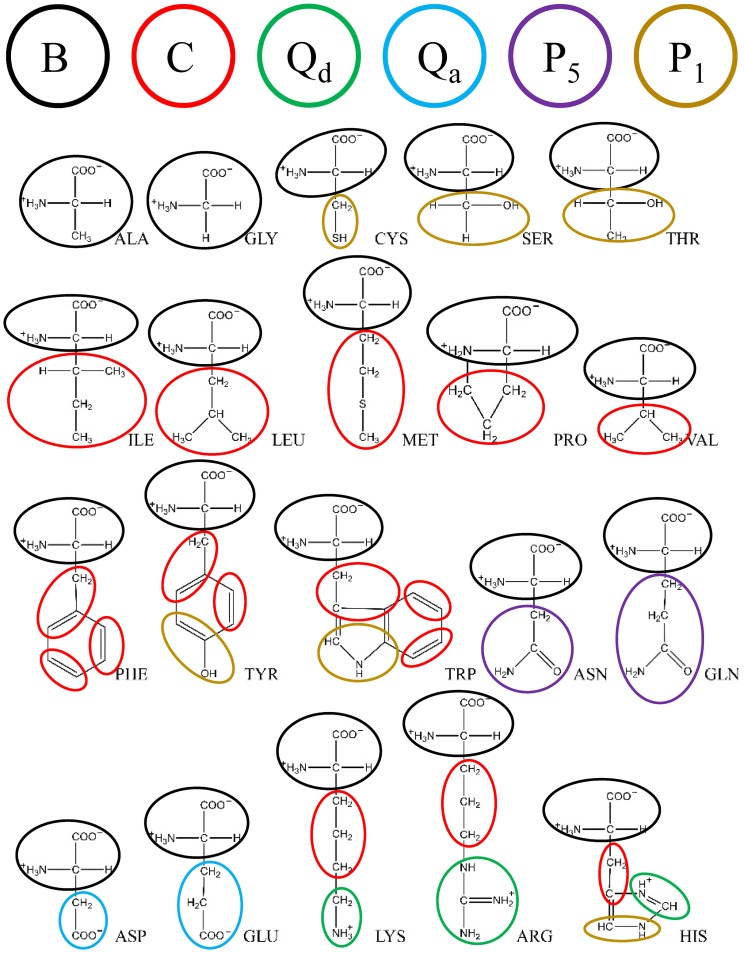
CG mappings for 20 amino acid residues.